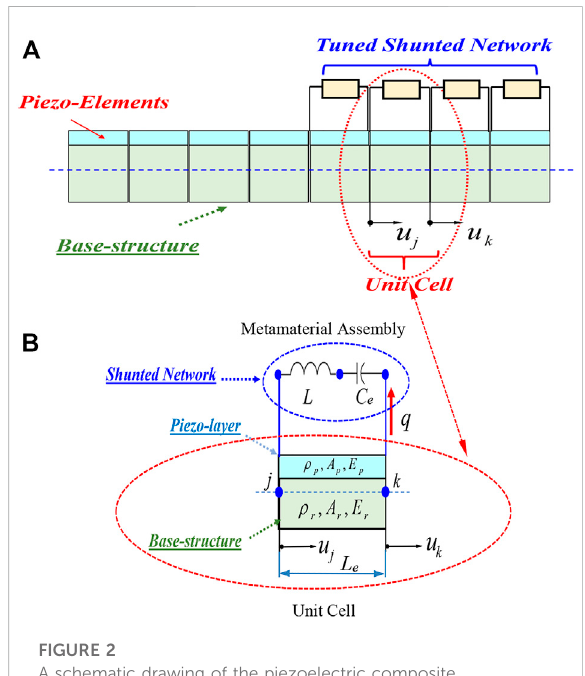
FIGURE 2 A schematic drawing of the piezoelectric composite